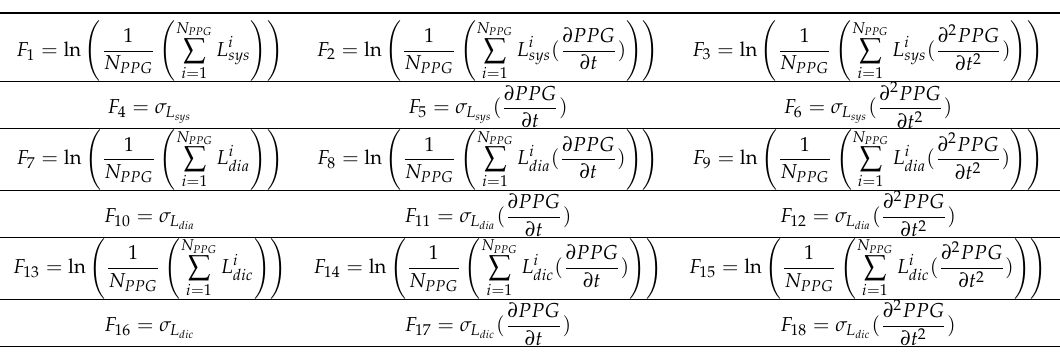
Table 1. Features from F 1 – F 18